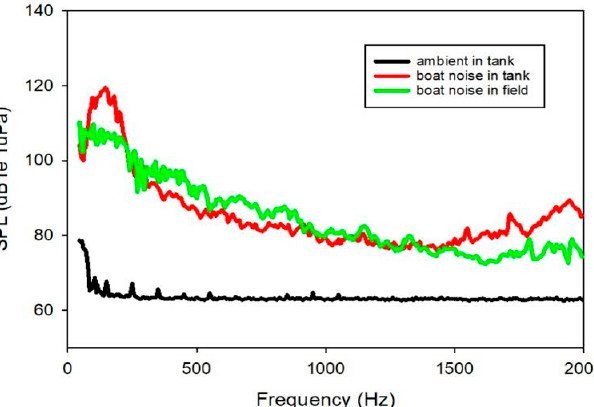
Figure 1. Sound pressure levels (SPL) in the experimental tank during boat noise playback (boat noise in tank) and boat noise recorded in mussel farm water (boat noise in the field) and ambient conditions in the experimental tank without playback (ambient in tank). The main frequency of boat noise in the tank is between 100 and 200 Hz, and owing to the space limitations of the tank, the boat noise in the tank was nearly 10 dB higher than the boat noise in the field.